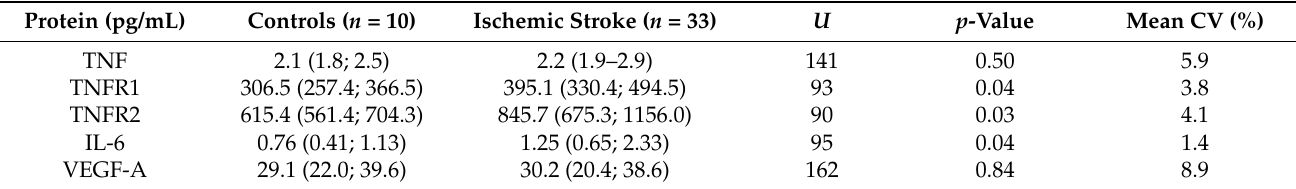
Table 3. Plasma cytokine, receptor, and growth factor levels. Data are presented as median (IQR). CV, coefficient of variation; IL-6, interleukin-6; TNF, tumor necrosis factor; TNFR1, tumor necrosis factor 1; TNFR2, tumor necrosis factor 2; VEGF-A, vascular endothelial growth factor-A; U , Mann–Whitney U